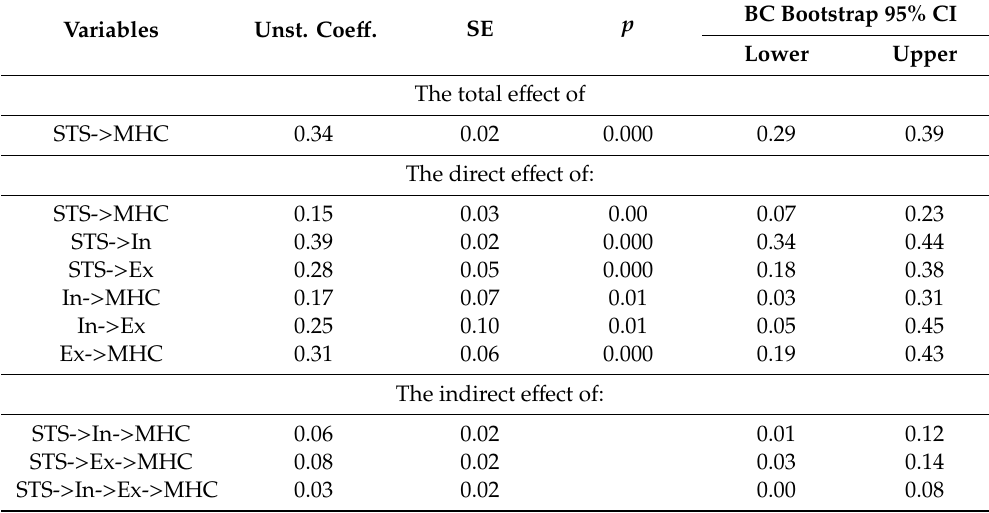
Table 3. Total, direct, and indirect e ff ects of the mediation model (PROCESS).